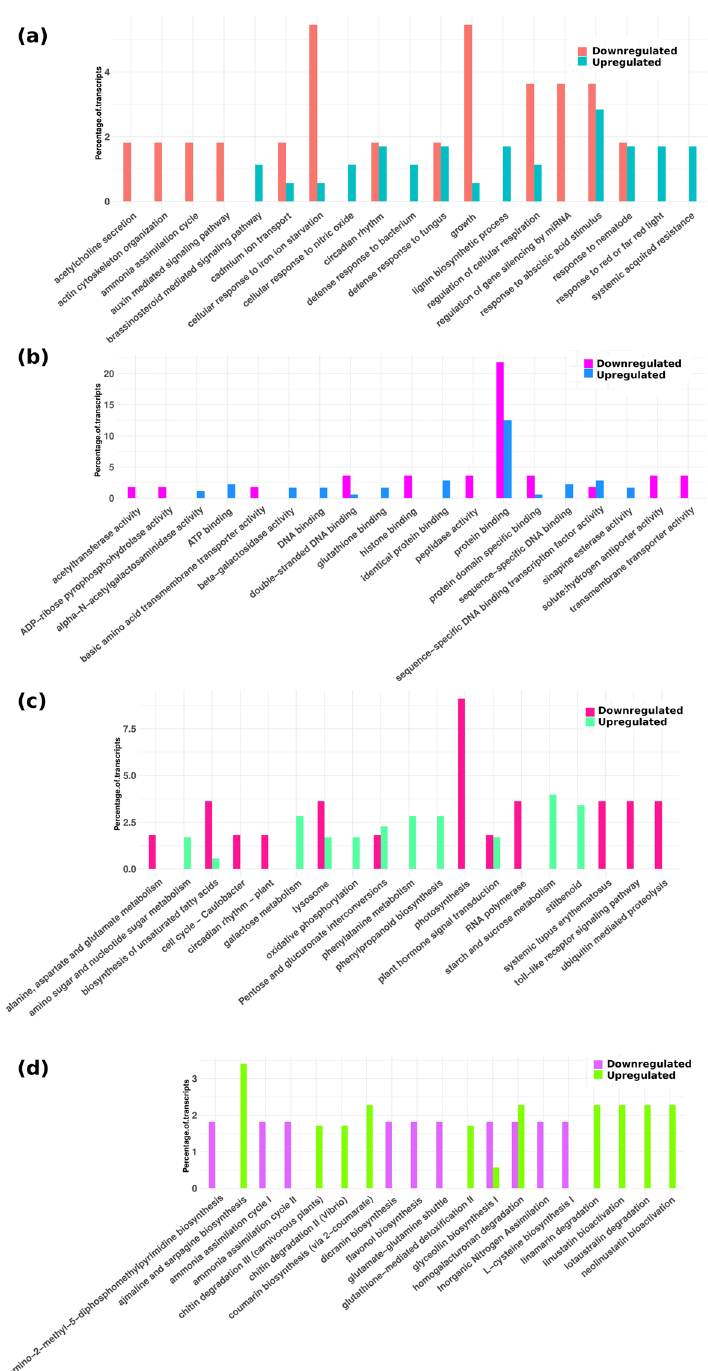
Figure 6. miRNA controlled genes abundance in different categorical annotations in leaf tissue ( a ) biological process in L25/L15 ( b ) molecular function in L25/L15 ( c ) KEGG pathways in L25/L15 ( d ) PMN pathways in